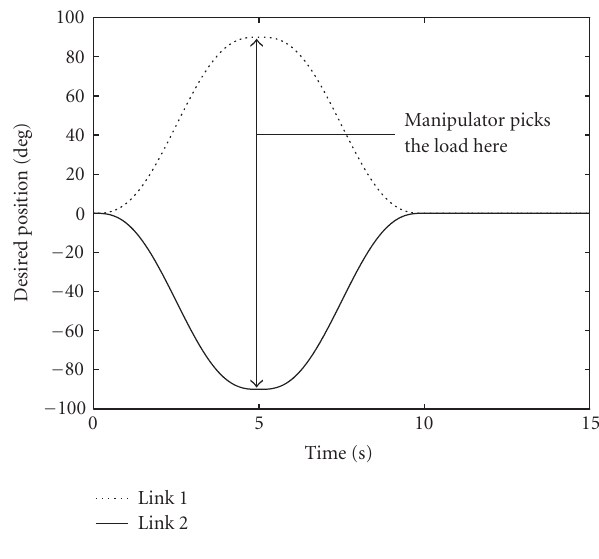
Figure 6: Desired trajectory